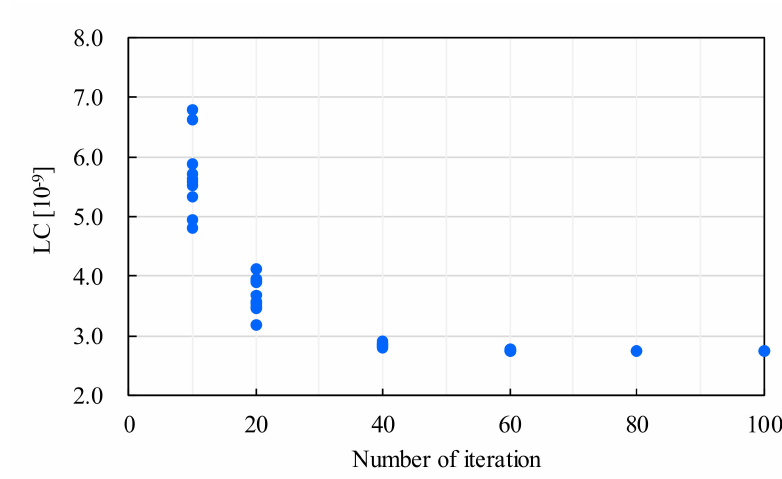
Figure 12. Relationship between number of iterations and value of LC (a feature whereupon parameter identification was